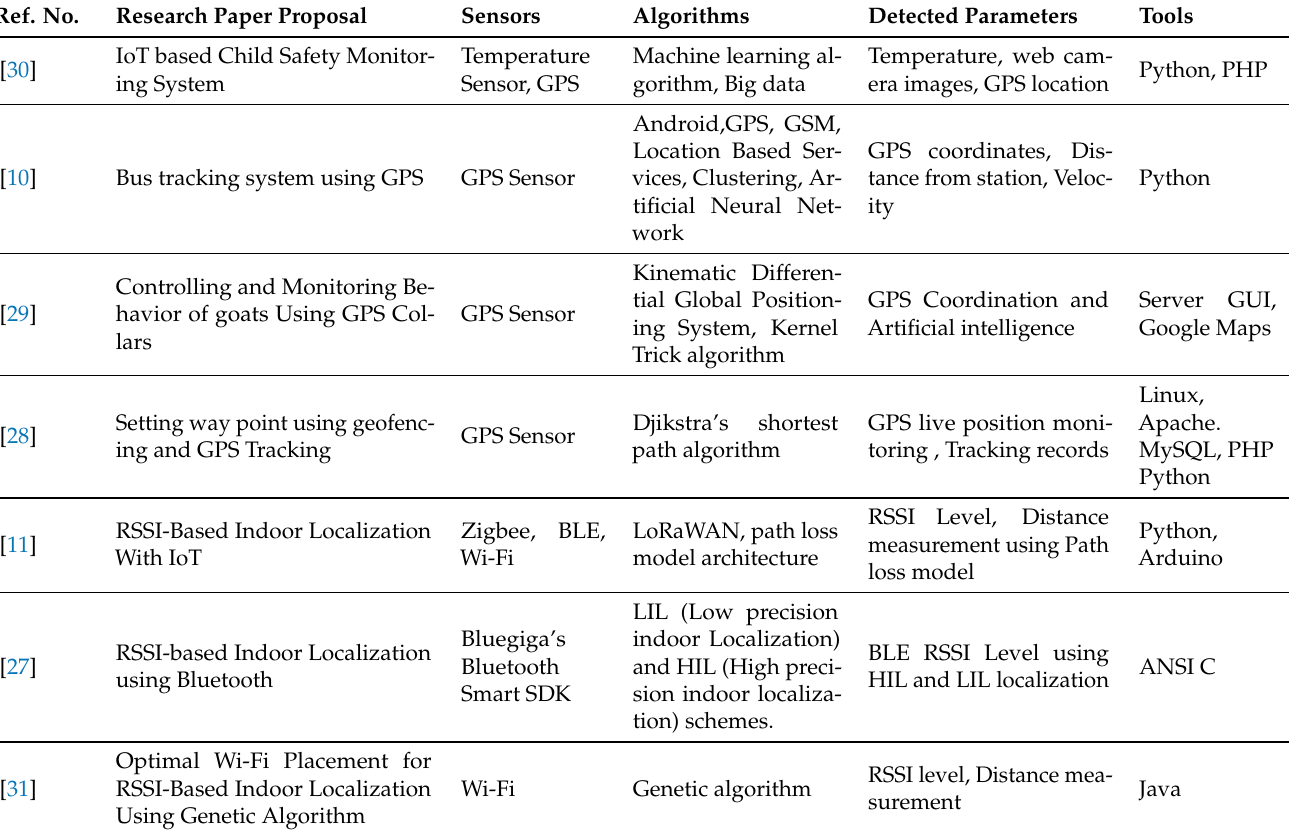
Table 3. Related work for surveillance detection using GPS and RSSI level integration. Ref.